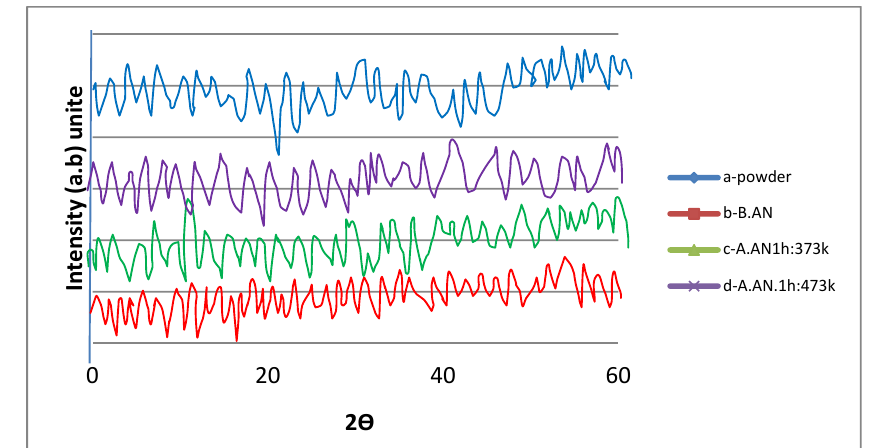
Fig. 1: X-ray diffraction of Ge